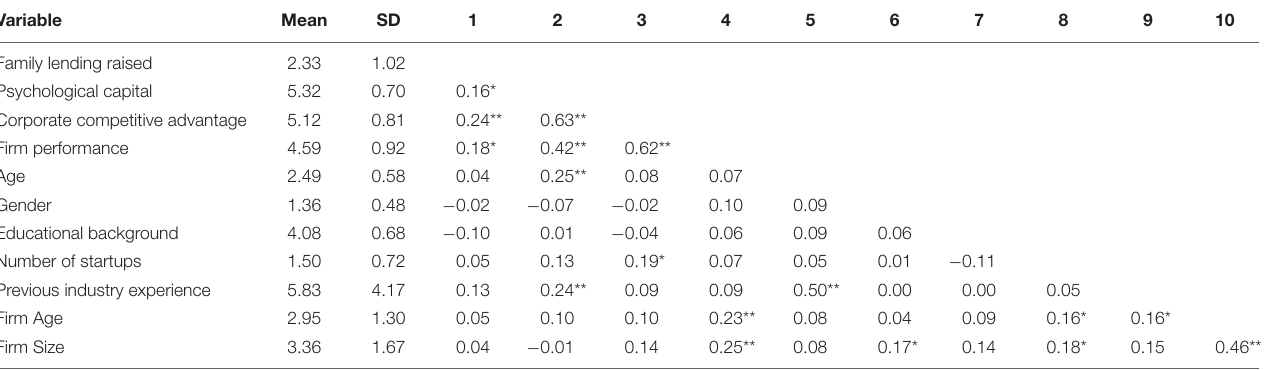
TABLE 3 | Descriptive statistical analysis.